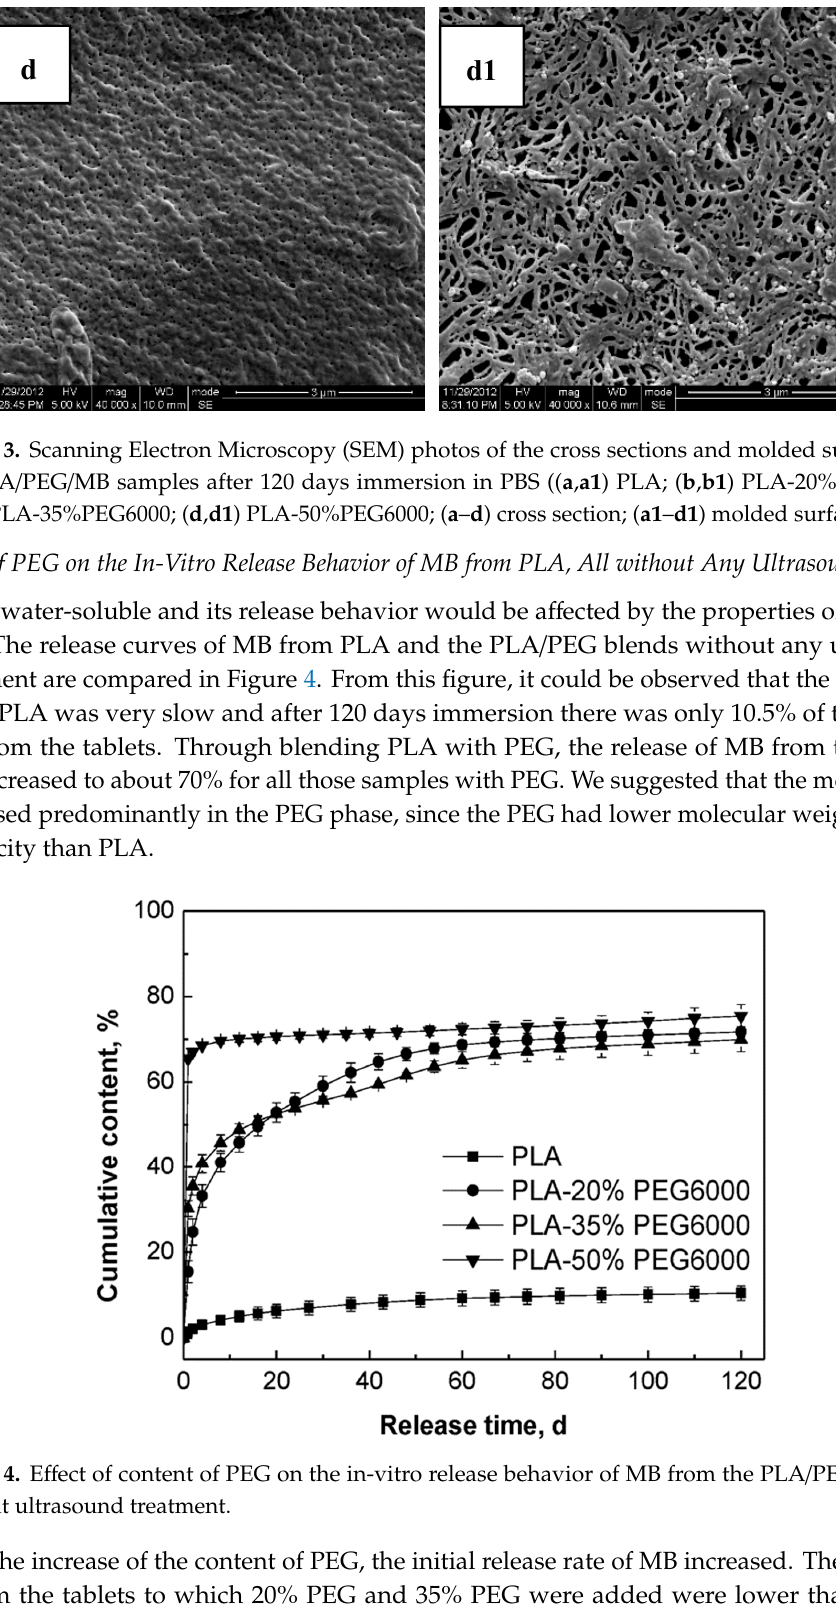
Figure 4. Effect of content of PEG on the in-vitro release behavior of MB from the PLA/PEG blends without ultrasound treatment.